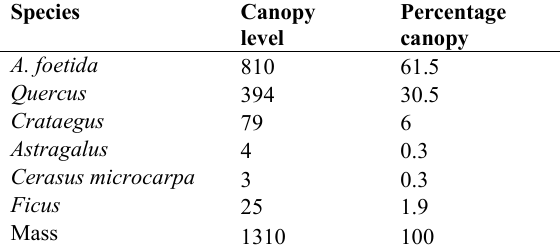
Fig. 3. Percentage of plant life forms (the Raunkiær system) in Kaseh-Garan area, Gilaneghaeb county: H) Hemicryptophyte; Hy) Hydrophyte; G) Geophyte; Ch) Chamaephyte; Ph) phanerophyte; T) Therophyte; Cr) Cryptophyte.